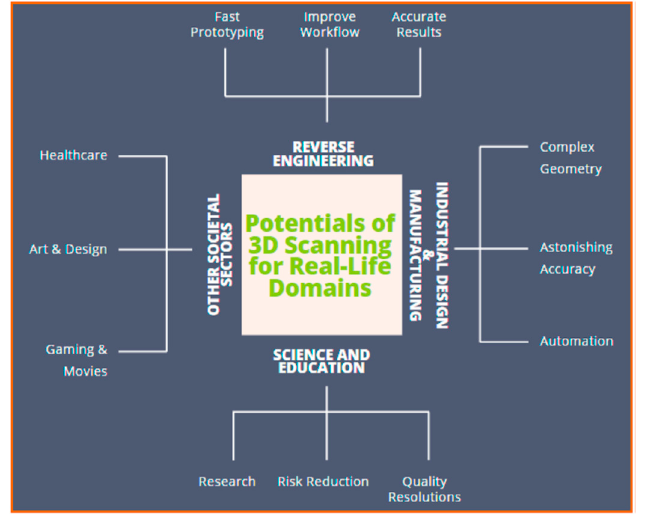
Figure 14. Potentials of 3D scanning for real-life domains [84].